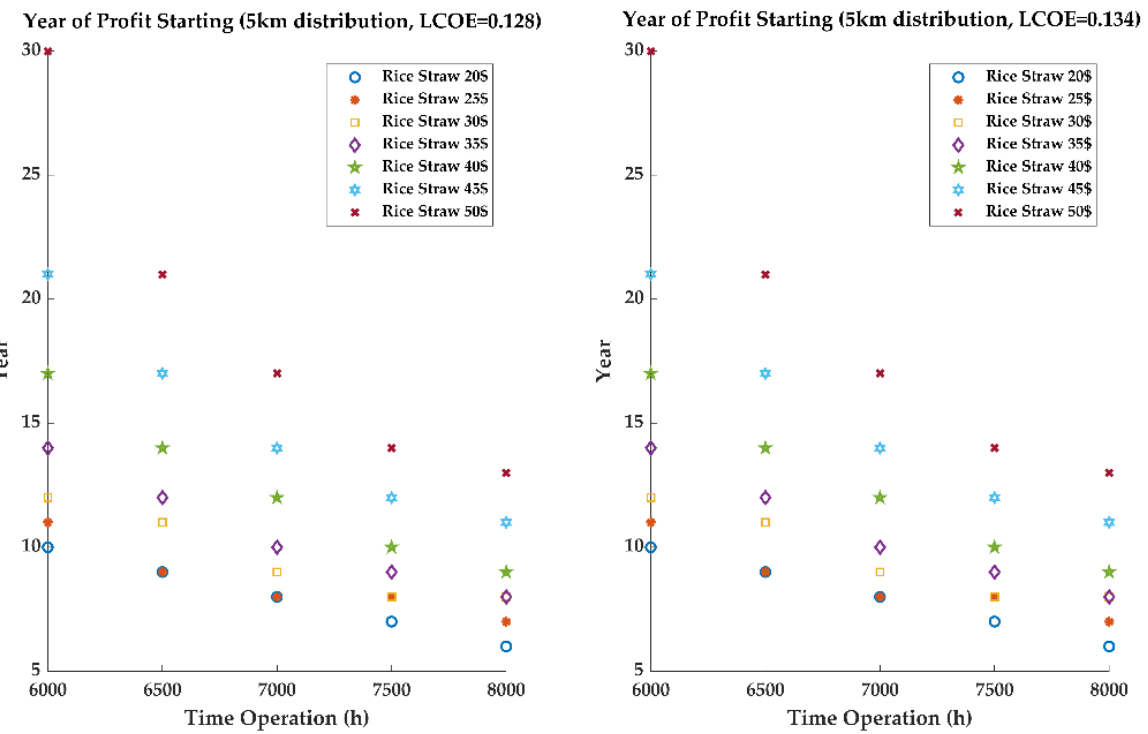
Figure 8. Year of profit starting at 5 km of medium voltage distribution length.